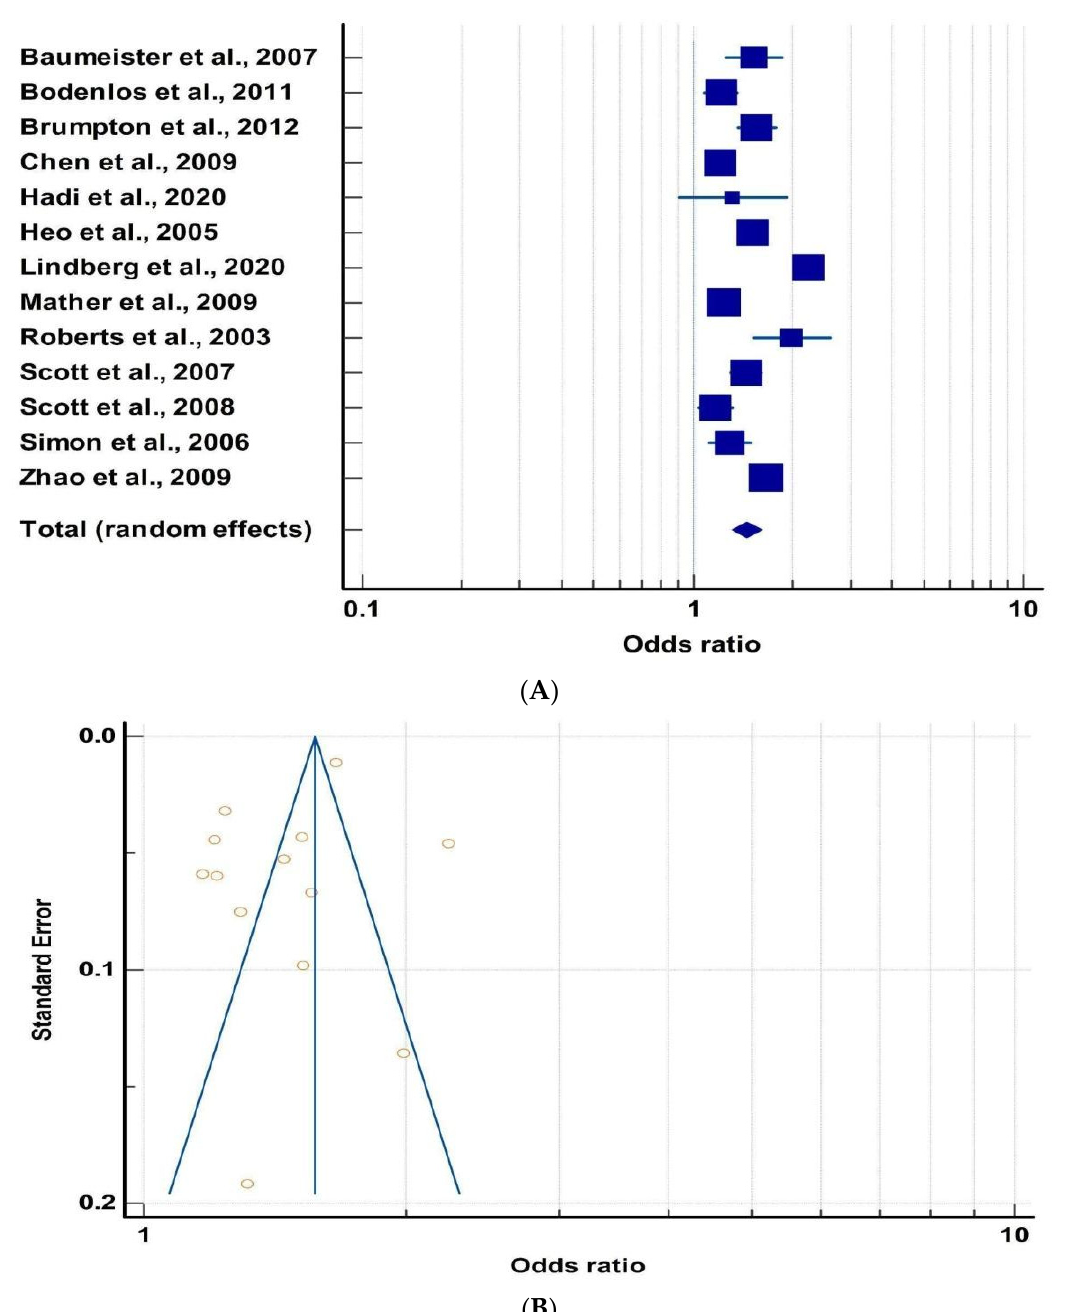
Figure 2. ( A ) Forest plot between obesity and mood disorders [9,44–55]. The box and the horizontal lines represent study specific OR and 95% CI, respectively. The size of the box is an indicator of the weightage of that study. Here, odds ratio greater than 1 suggest the odds of mood disorders are higher in obese people in comparison to normal controls. ( B ) Funnel plot of obesity and mood disorders for publication